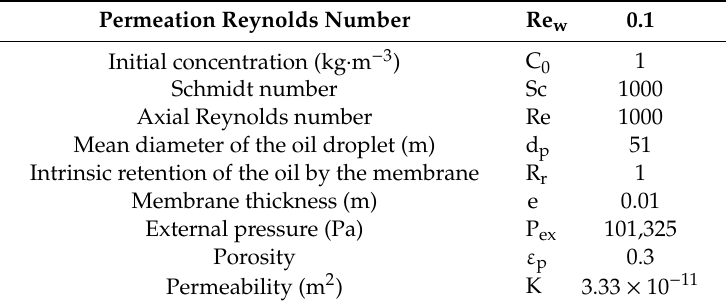
Table 5. Parameters considered constant in simulations.